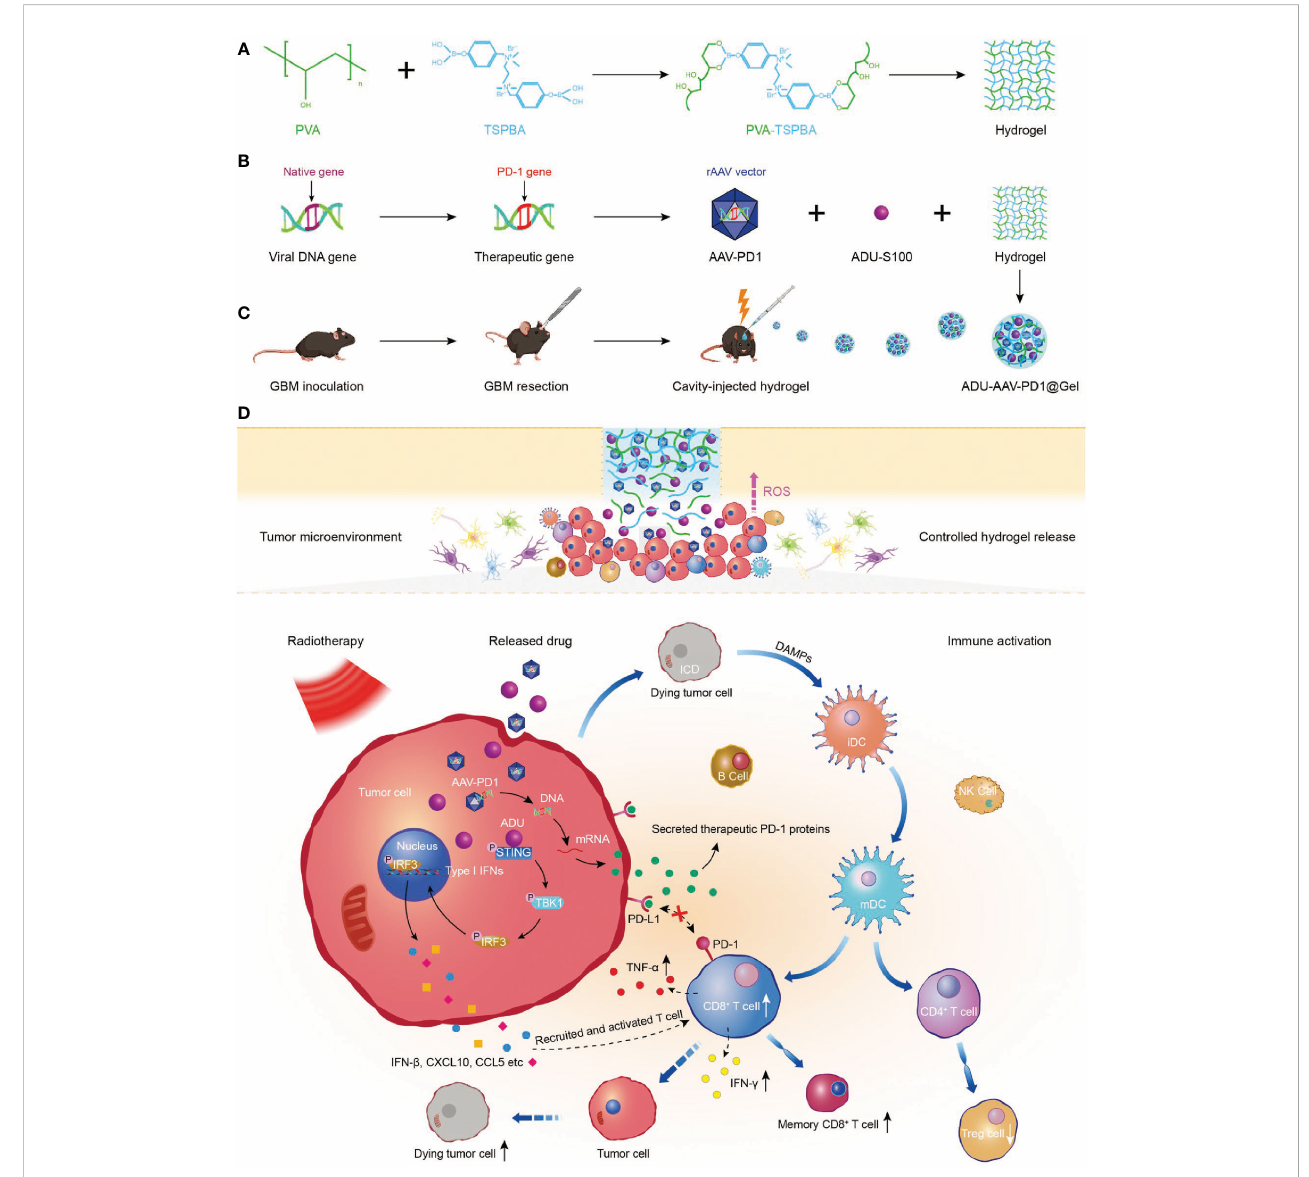
FIGURE 7 Preparation and mechanism of ADU-AAV-PD1@Gel. (A) Schematic illustration of the preparation of PVA-TSPBA hydrogel. (B) Flowchart of generation of the AAV-PD1 and formation of the ADU-AAV-PD1@Gel. (C) The ADU-AAV-PD1@Gel combined with RT treatment was performed in the GBM resection mice model. ADU-AAV-PD1@Gel was injected into the GBM resection cavity on day 11 after the GBM inoculation. The RT was performed on day 12, 13, and 14. (D) Mechanism of combining ADU-AAV-PD1@Gel with RT treatment for synergetic radioimmunotherapy of post-resection glioma